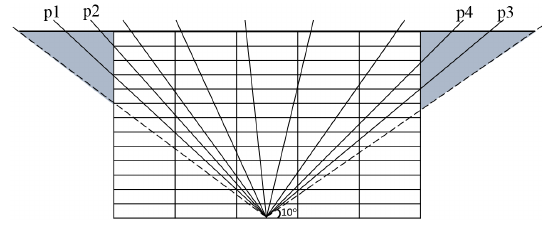
Figure 2. Plane distribution of satellite